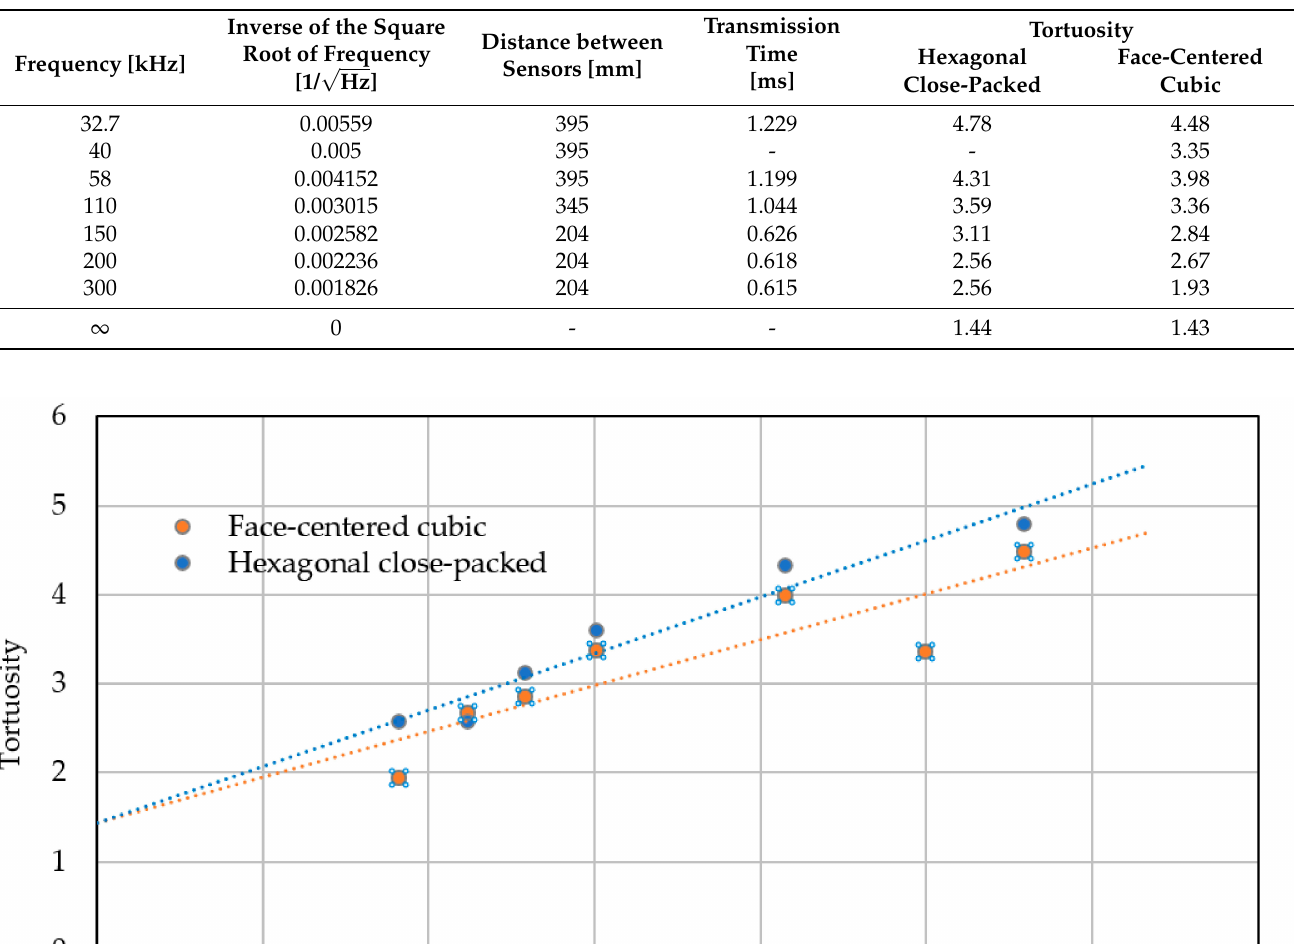
Table 2. Measurement results of the tortuosity.